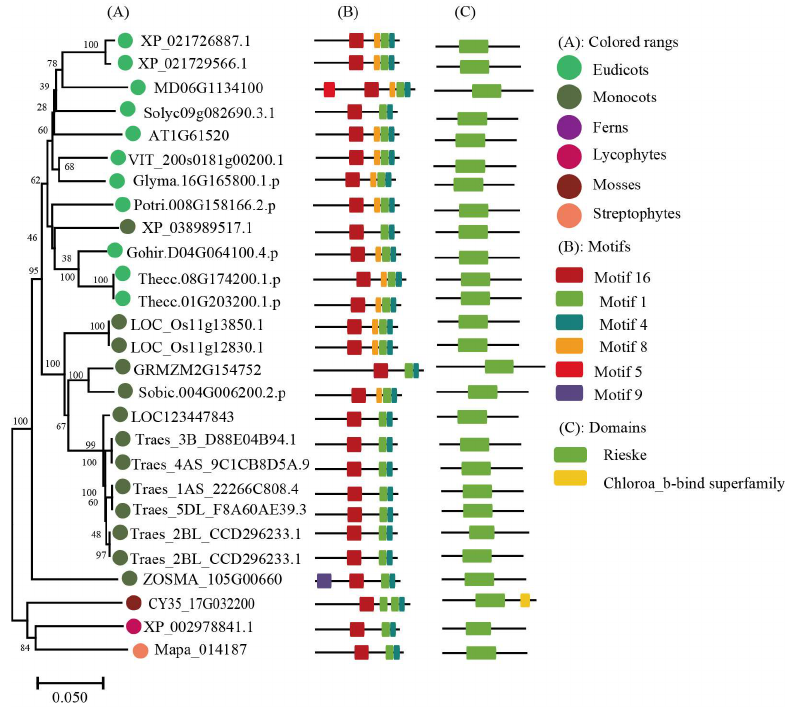
Figure 5. Phylogenetic evolutionary tree, protein motifs, and domains of the Psb33 subfamily members: ( A ) Unrooted phylogenetic tree of the Psb33 subfamily; ( B ) motifs of the Psb33 proteins. The different colors indicate six motifs (left panel); ( C ) protein domains of the Psb33 genes.